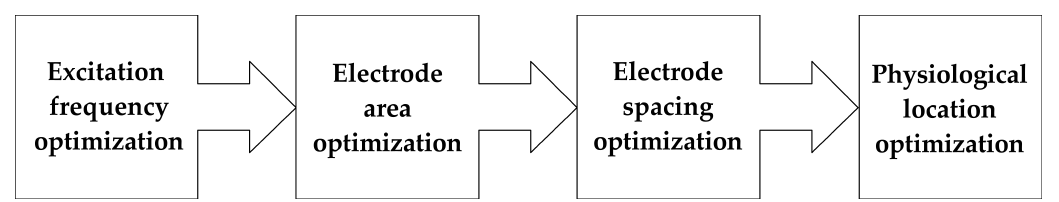
Figure 5. Flow chart of the step-by-step optimized procedure for measurement